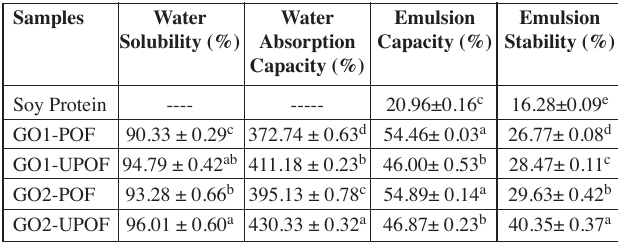
Tab. 4: Techno-functional properties of oleaster flour samples. a*